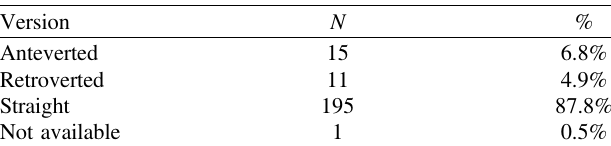
Table A.5. Kinectiv neck version.